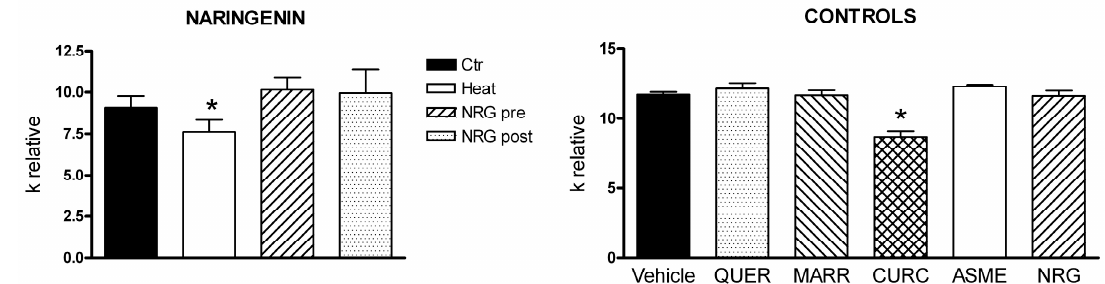
Figure 5. Effect of naringenin (NRG), ASME, quercetin (QUER), marrubiin (MARR), and curcumin (CURC) on the water permeability of HeLa cells in normal and heat-stress conditions. HeLa cells were exposed to a 150 mOsm osmotic gradient in four different conditions: (1) untreated cells (Controls, Ctr); (2) cells treated at 42 ◦ C for 3 h (heat-stressed, Heat); (3) heat-stressed cells pre-treated with the antioxidants compounds (NRG, ASME, QUER, MARR, CURC pre); (4) heat-stressed cells post-treated with the antioxidants compounds (NRG, ASME, QUER, MARR, CURC post). The effect of NRG, ASME, QUER, MARR, CURC on water permeability independently on their antioxidant properties was measured in HeLa cells treated at 21 ◦ C for 3 h with single compounds at 20 µ M final concentration. Bars represent the osmotic water permeability of HeLa cells expressed as k relative. Values are means ± SEM of 4–15 single shots for each of 4–6 different experiments. NRG, ASME, QUER and MARR: * p < 0.05 vs. Ctr, pre and post (ANOVA for repeated measures, followed by Newman–Keuls’ Q test). CURC: * p < 0.05 vs. Heat, pre and post; ◦ p < 0.05 vs. pre and post (ANOVA for repeated measures, followed by Newman–Keuls’ Q test). CONTROLS: * p < 0.05 vs. vehicle (ANOVA followed by Dunnett t test).